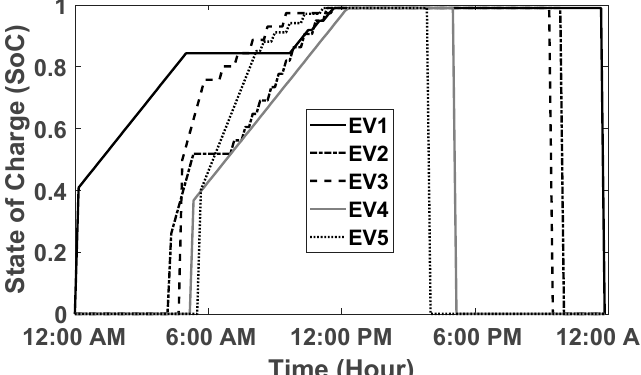
Figure 3. State of Charge of Randomly Selected EV.